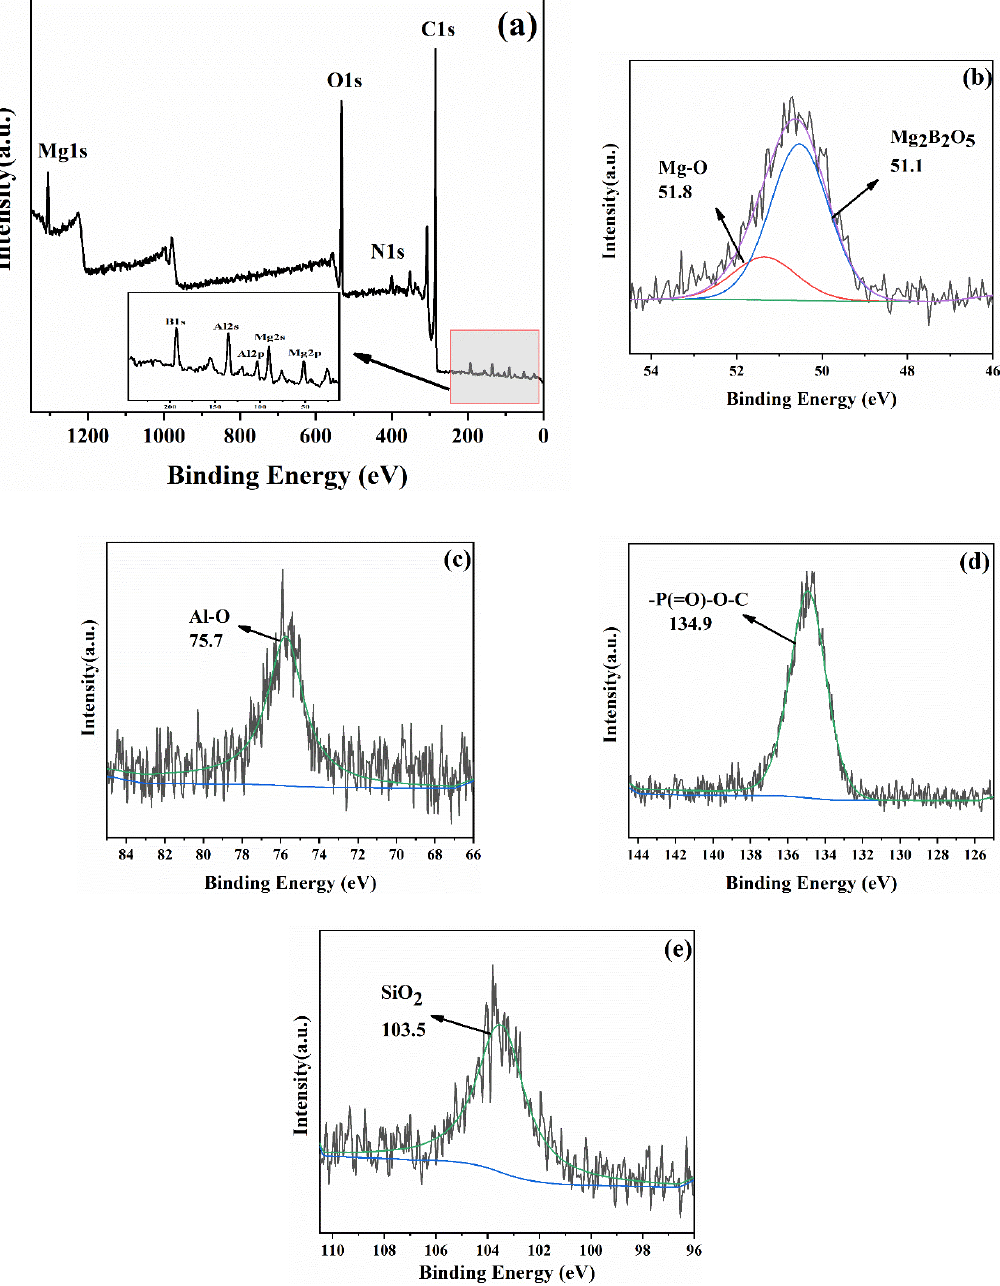
Figure 15. ( a ) Full-scan XPS spectral profiles of char residue derived from EP/7.5MBR@LDHP-APES, and high-resolution XPS spectral profiles obtained for ( b ) Mg2p, ( c ) Al2p, ( d ) P2p and ( e ) Si2p. 430